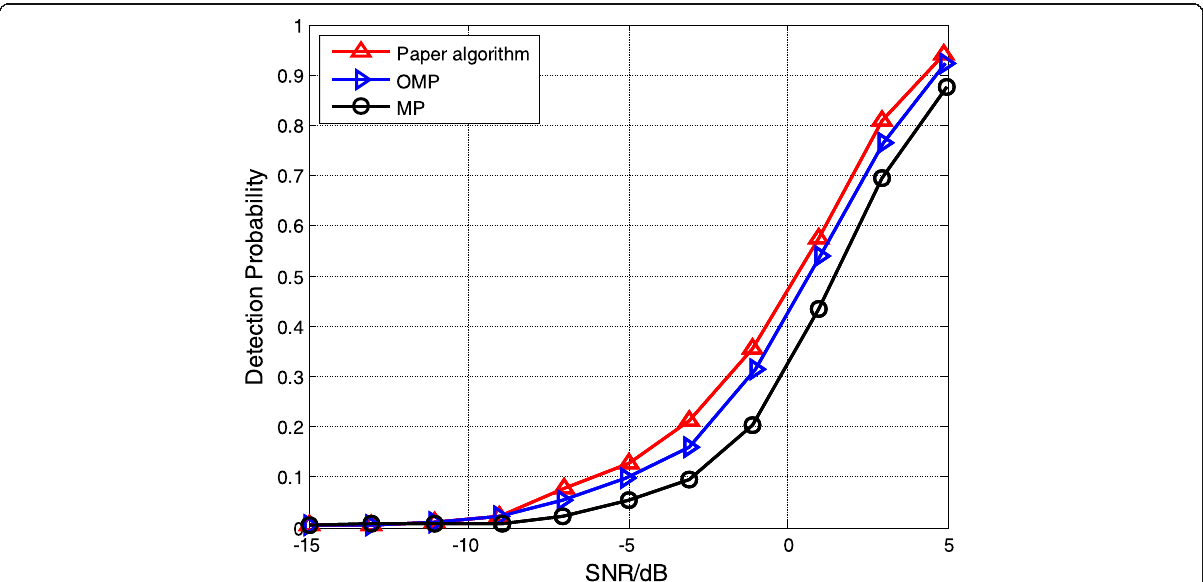
Fig. 3 The curve of the relationship between SNR and detection probability. Considering the change of SNR between – 15 db and 5 dB, we can compare the detection probability of the paper algorithm and the classical algorithm in the case of different number of cooperative users. After the cognitive user obtains the local detection results through compressed sensing, the detection probability is obtained according to the actual spectrum occupation of the channel and the simulated spectrum occupation. With the increase of the number of cooperative users, our method has higher detection probability than the traditional method. However, no matter it is single-user detection or multi-user detection, it is not difficult to find that when the SNR is very low, the detection probability is very low between – 15 db and 10 dB, and the performance of cooperative spectrum detection does not have many advantages. This low SNR state is equivalent to a severe shadow-fading or other fading in real environments. Cognitive users in this environment will affect the performance of cooperative spectrum detection and even reduce the detection performance of cognitive users with high SNR. Therefore, synergetic spectrum detection not only improves the detection performance, but also reduces